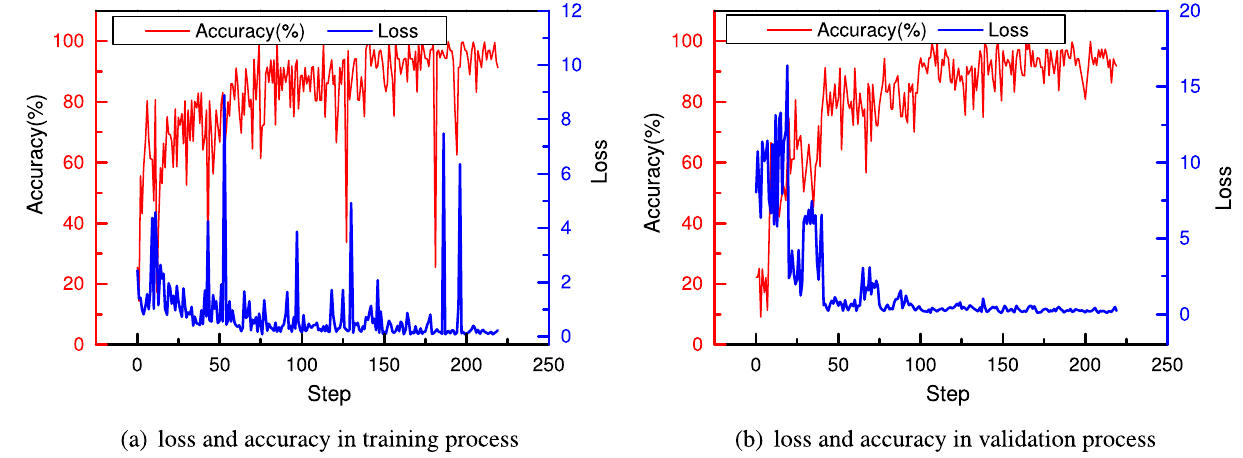
Figure 6. Loss and accuracy in the training process ( a ) and validation process ( b ) in the search phase.